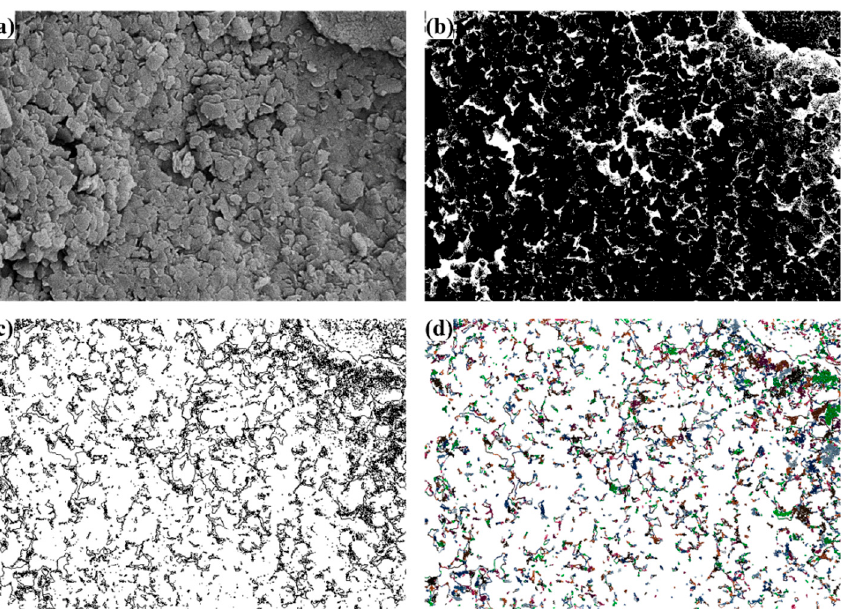
Figure 1. The procedure of pore recognition for fractal dimension D 1 : ( a ) Original SEM image; ( b ) Binary image; ( c ) Recognition of pore margins; ( d ) Calculations of perimeter and area.